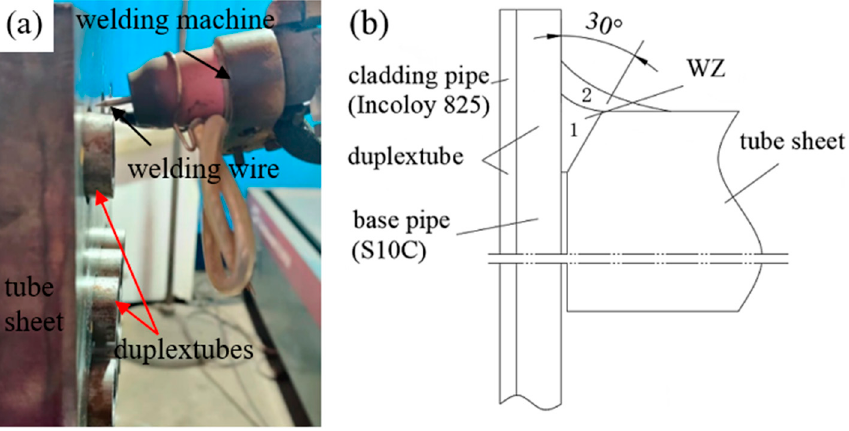
Figure 1. Digital camera photo ( a ) of welding machine and schematic diagram ( b ) of welded joints (WZ: weld zone, 1—the first weld seam, 2—the second weld seam). Table 1. Chemical composition of duplextube tubes, plates and filler metals (wt.%). Element Fe